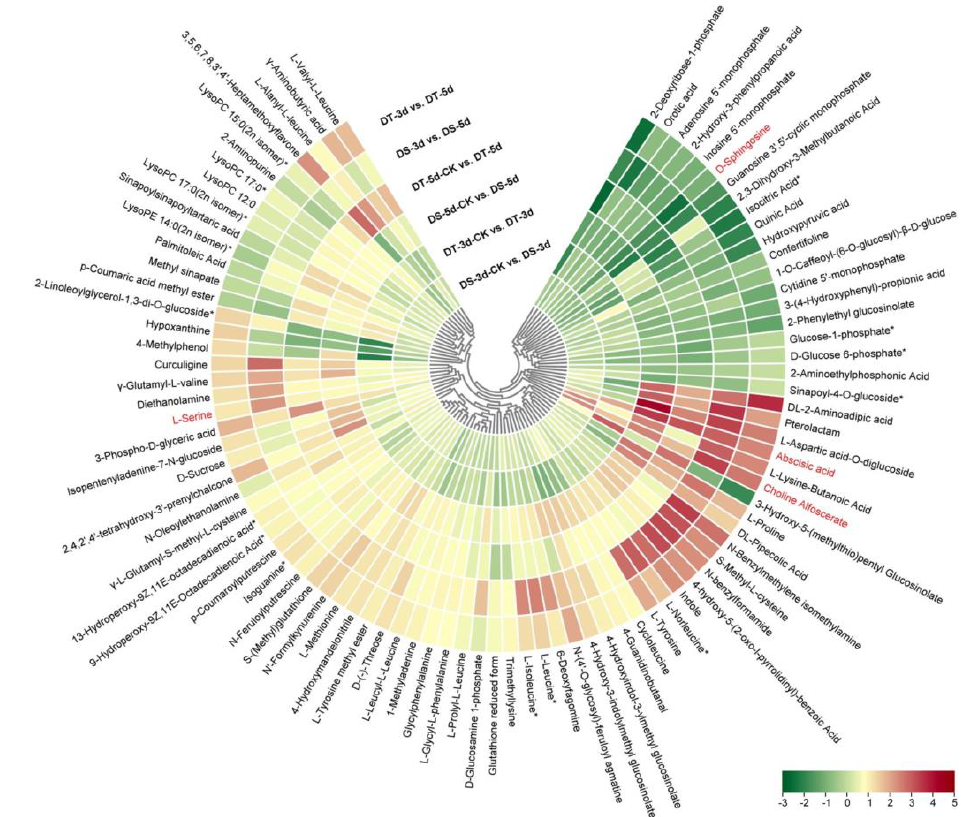
Figure 6. Heatmap of 90 drought − responsive metabolites in Chinese cabbage was constructed based on Log 2 ratios of fold changes. The metabolites labeled in red were considered as potential biomarkers of drought stress in Chinese cabbage. The Log 2 (fold changes values) and the color scale are shown at the bottom right of heatmap.